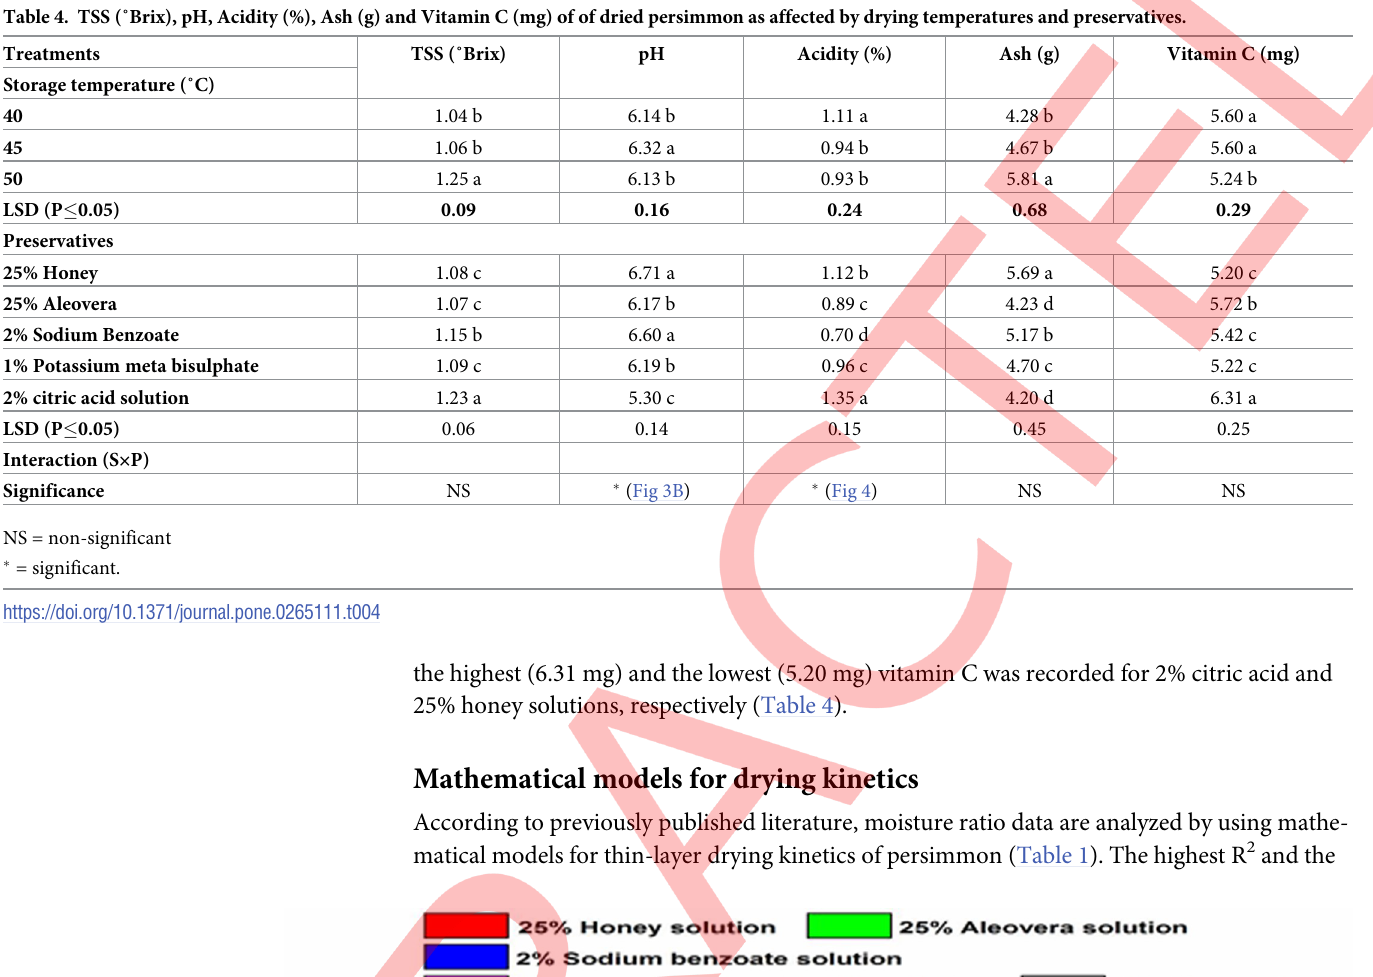
Table 4. TSS (˚Brix), pH, Acidity (%), Ash (g) and Vitamin C (mg) of of dried persimmon as affected by drying temperatures and preservatives. Treatments